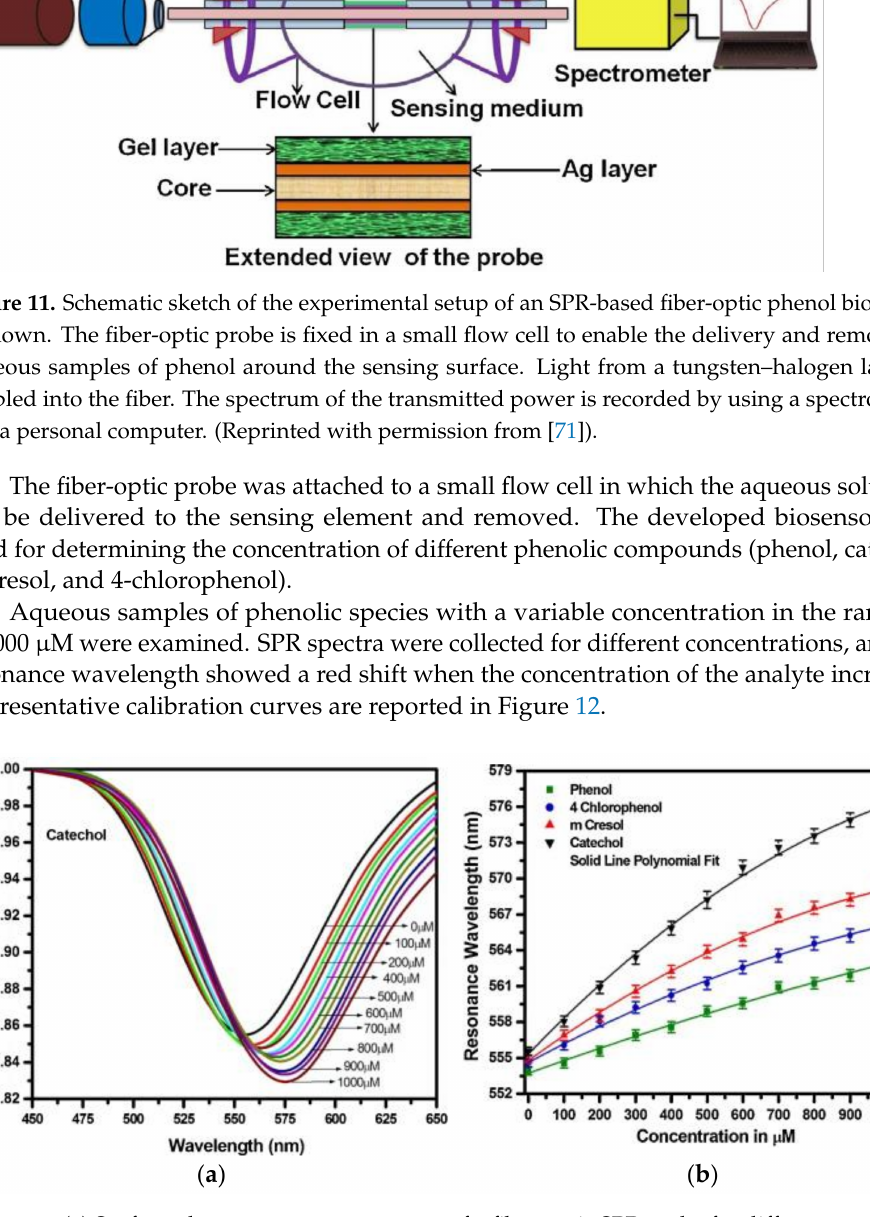
Figure 12. ( a ) Surface plasmon resonance spectra of a fiber-optic SPR probe for different concentra- tions of catechol, ( b ) Calibration curves obtained by measuring the variation in resonance wave- length for different concentrations of various phenol species. (Reprinted-adapted-with permission from